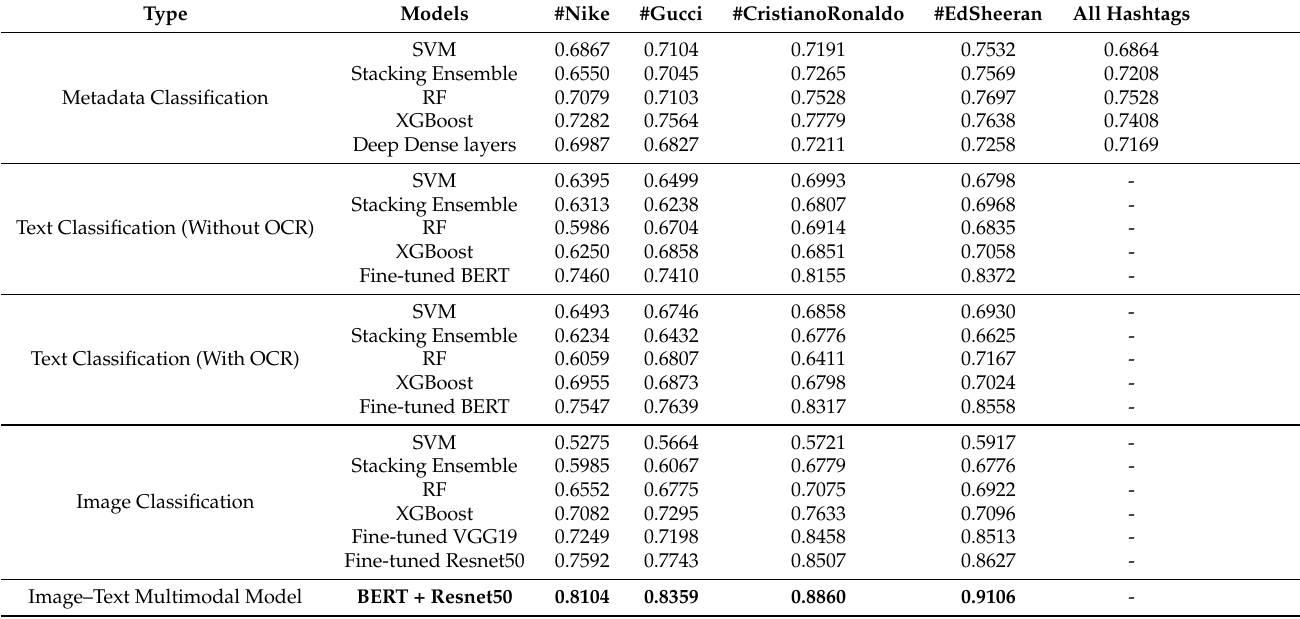
Table 5. The F-Score of the models on the test set. The best-performed model shows in bold.